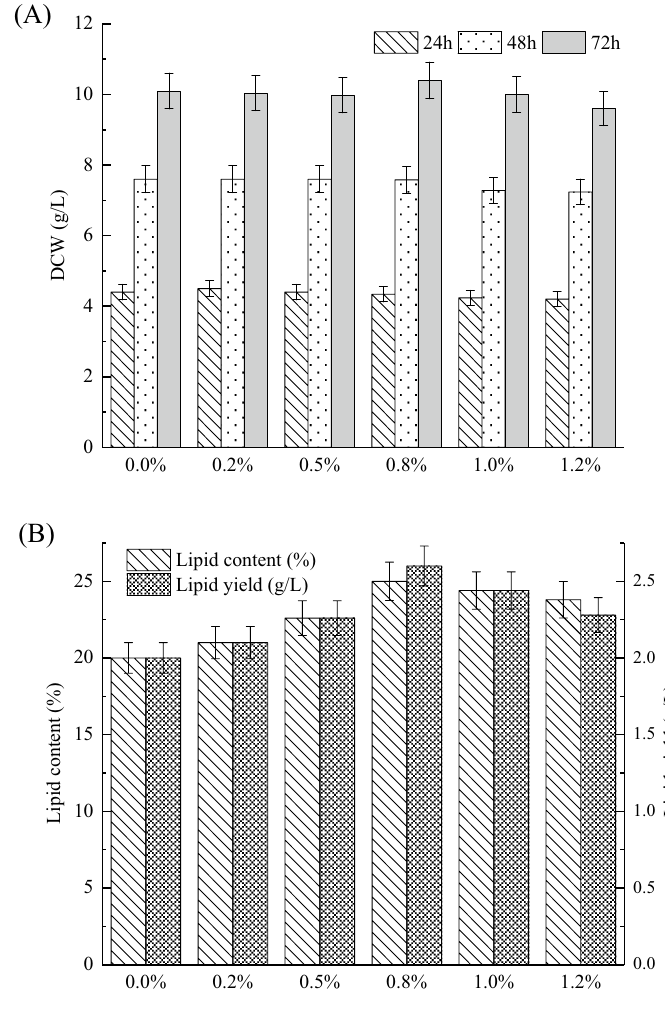
Figure 2. Comparison of cell growth ( A ) and lipid production ( B ) of Mc-MT-2 in batch cultures containing different concentration (0–1.2%, w/w) of malic acid. Values were mean of three independent fermentation experiments. Error bars represent the standard error of the